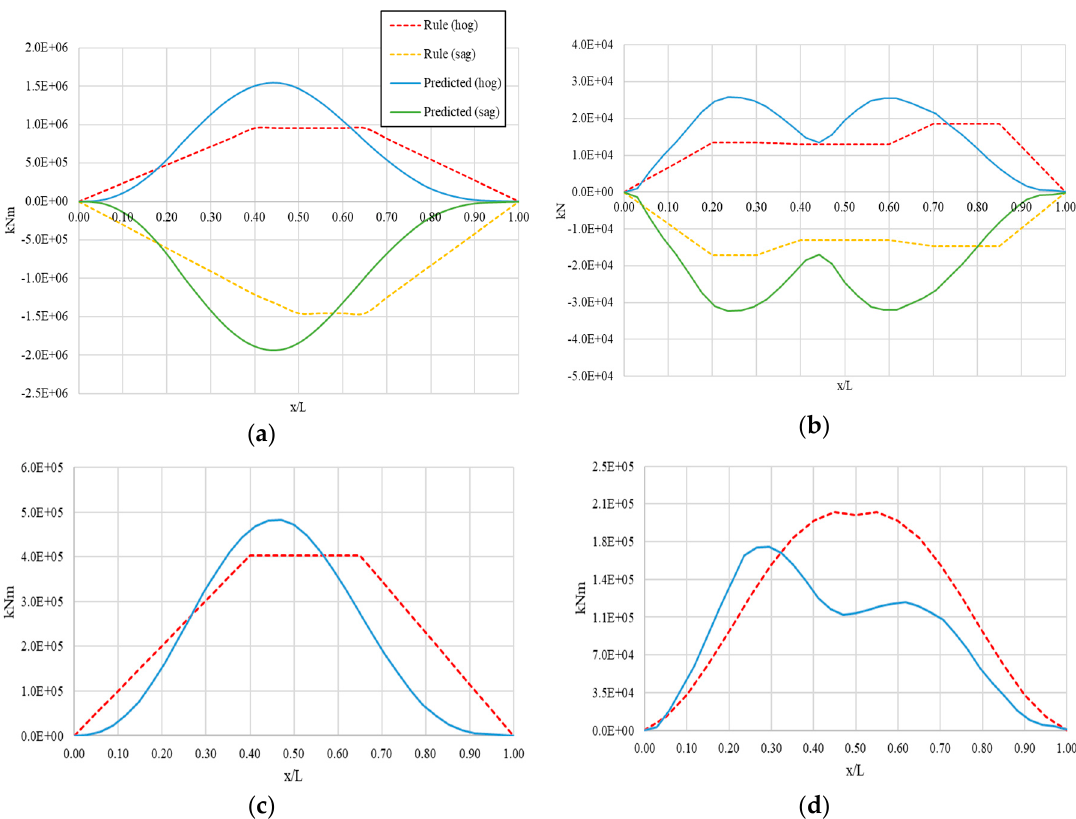
Figure 13. Comparison of load envelope curves between predictions and Rule-based values (10 − 8 probability level, 25 years return period); (a) Vertical Bending Moment – VBM; (b) Vertical Shear Force VSF; (c) Horizontal Bending Moment – HBM; (d) Torsional Moment – TM..